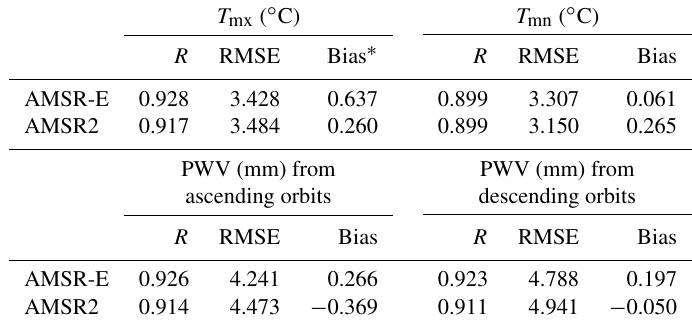
Table 2. LPDR daily T mn , T mx , and ascending- or descending-orbit-based PWV accuracy in relation to respective in situ air temperature measurements and AIRS PWV observations for 142 global WMO site locations for the selected years 2010 (AMSR-E) and 2013 (AMSR2).